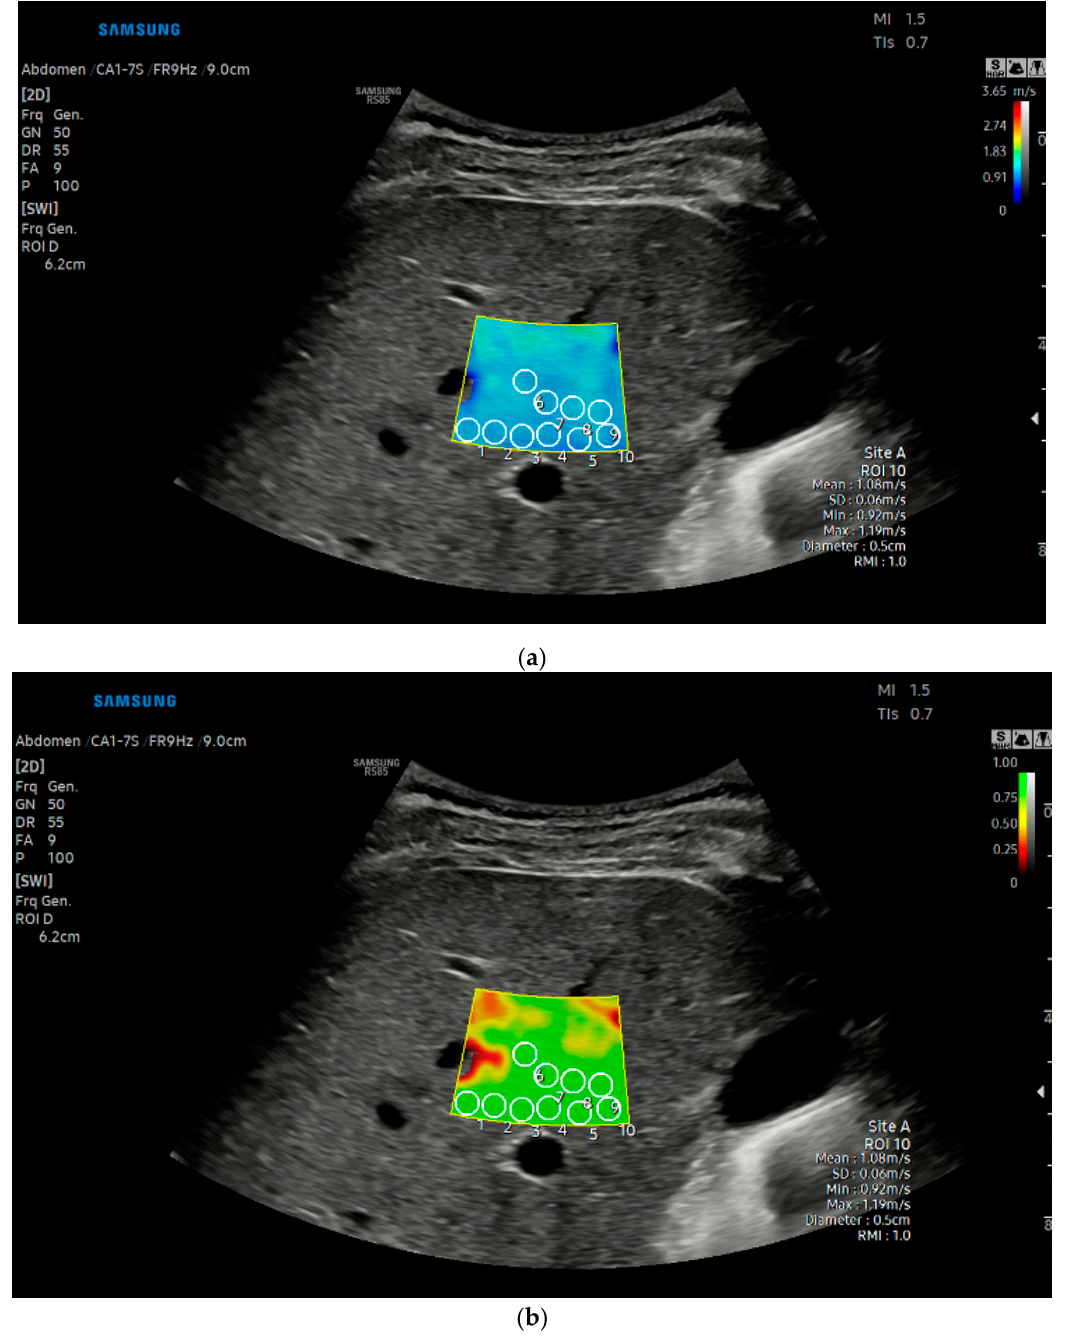
Figure 2. Liver stiffness (LS) measurement with 2D shear wave elastography (SWE). ( a ) SWE measurement of a liver with no significant fibrosis. The LS was reported in m/s units. ( b ) Color-coded map of the RMI was used for the ROI selection during 2D-SWE of a liver with no significant fibrosis.